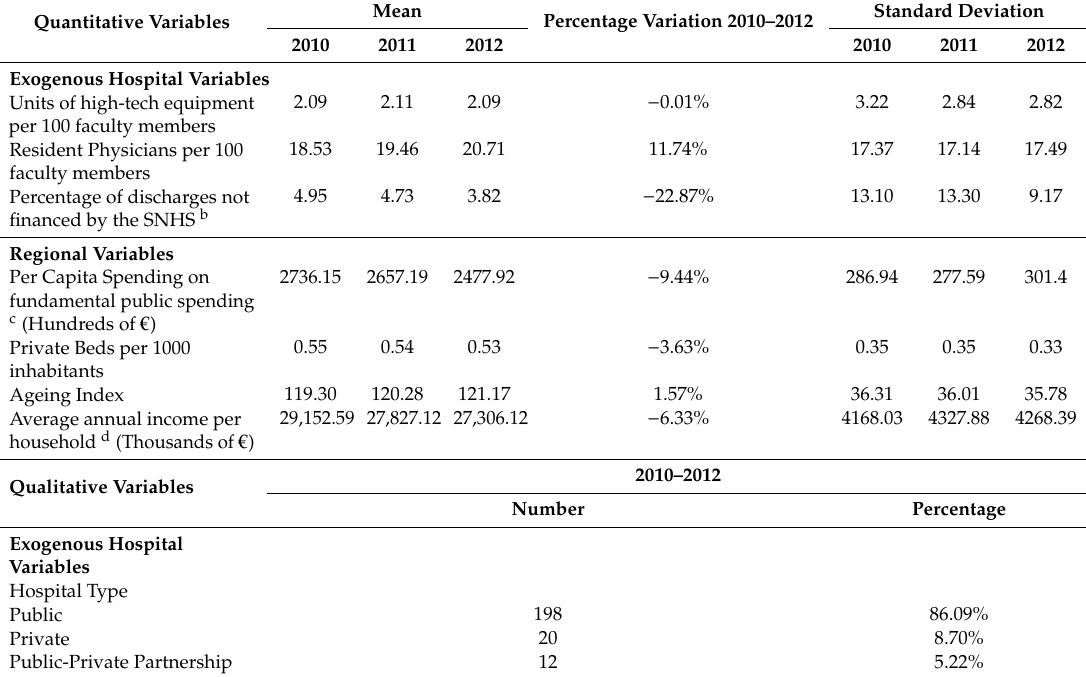
Table 3. Regional and hospital variables in the second stage analysis in the evaluation of technical e ffi ciency of Spanish National Health System general hospitals.